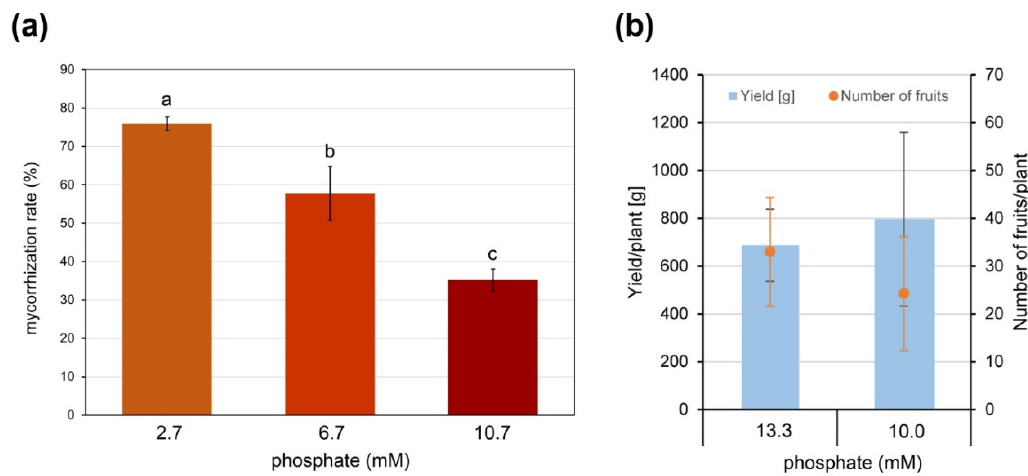
Figure 1. Effect of Pi-availability on formation of arbuscular mycorrhiza (AM) and yield. ( a ) Mycorrhization rate of roots of cv. Brioso inoculated with Rhizophagus irregularis and fertilized with 10 mL Long Ashton fertilizer containing 2.7, 6.7 or 10.7 mM Pi twice a week. Roots were harvested 17 weeks after inoculation. Shown are mean values ± SD ( n = 3). Different letters indicate significant differences tested by 1-factorial ANOVA followed by Tukey HSD-test with p < 0.05. ( b ) Yield and number of fruits per plant of cv. Brioso under different fertilizer regimes. Plants were grown for 8 months and fertilized via drip irrigation using Long Ashton fertilizer containing 13.3 or 10.0 mM phosphate. Shown are mean values ± SD ( n = 4).